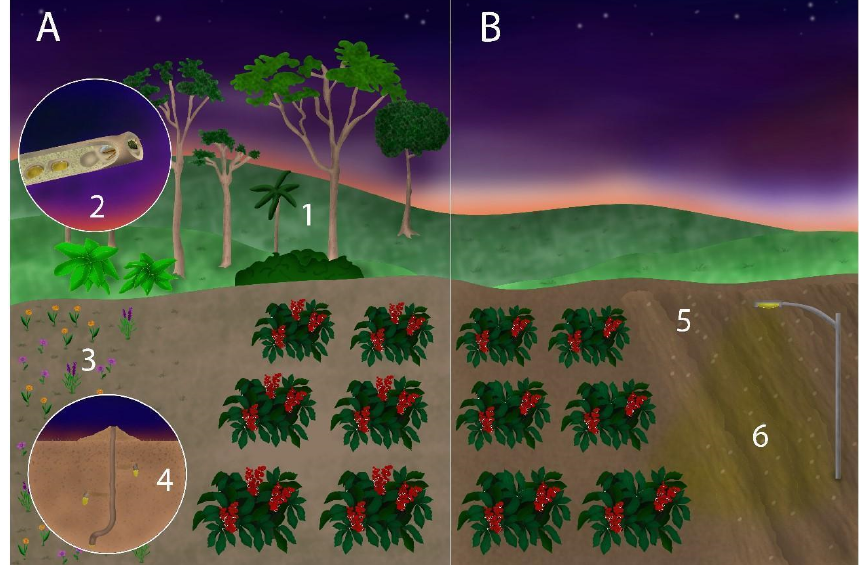
Figure 2. Comparing a more ( A ) and a less ( B ) sustainable crop area for hosting high numbers of nocturnal bee pollinators. Adjacent natural areas to provide food ( 1 ) and nest ( 2 ) resources; a range of cultivated, native flowering species offer food beyond the crop flowering season ( 3 ); potential nesting sites of ground-nesting species (e.g., Ptiloglossa ) should be identified and protected ( 4 ); soil disturbance, such as that caused by deep tillage, fire, and superficial movements in the area by agricultural machines should be minimized, at least during the flowering season ( 5 ); artificial light pollution at night (ALAN) near crop areas should be avoided ( 6 ).